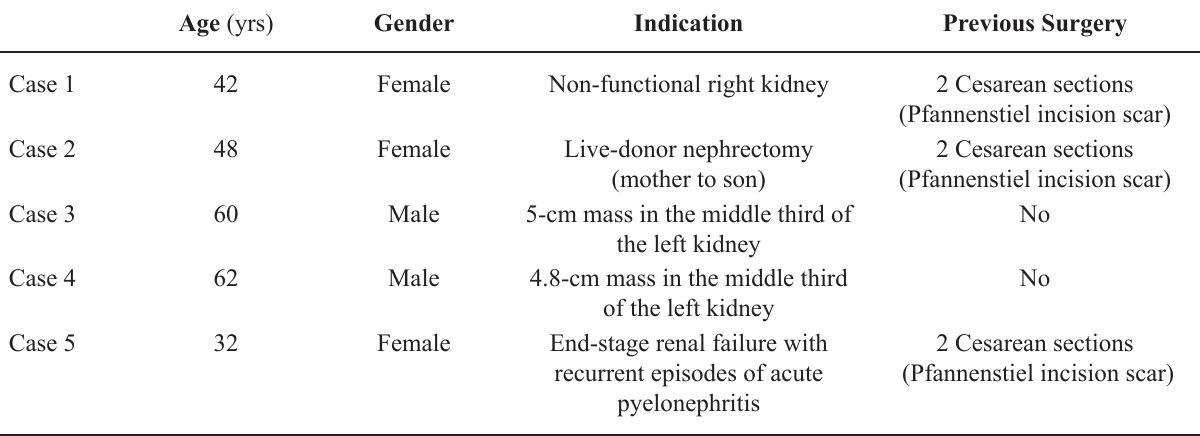
Table 1 – Patients’ demographics and indications for the